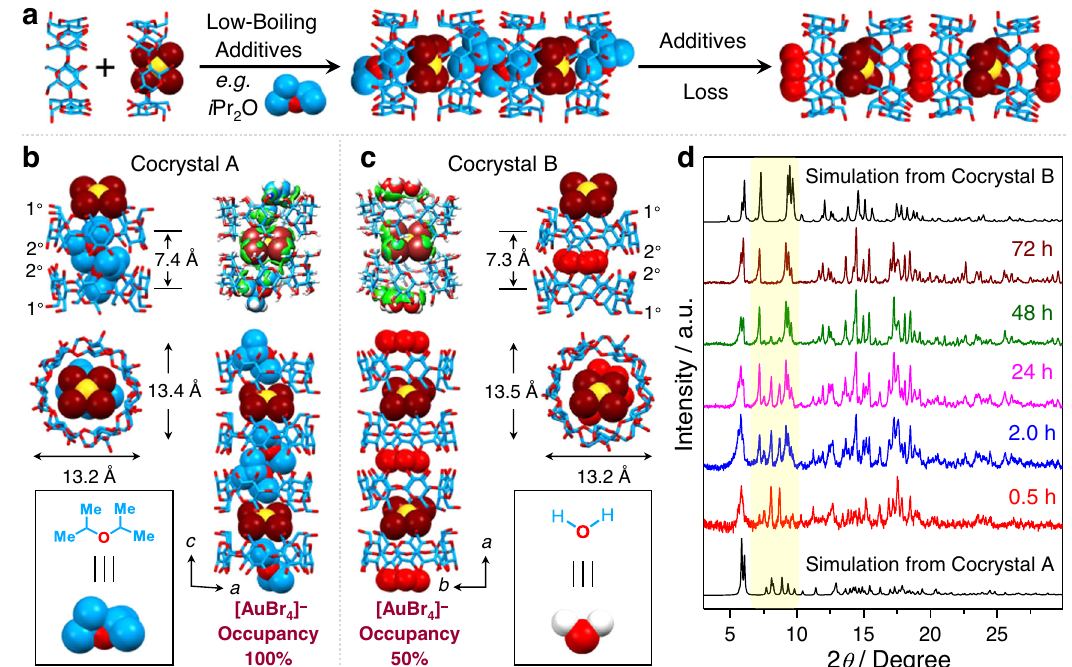
Fig. 4 | Cocrystal-to-cocrystal transformation of the ternary adducts. It shows the possible reason for different additives leading to variable gold-recovery ef fi - ciencies. a Schematicillustrationofthecocrystal-to-cocrystaltransformationupon loss of additives. b Solid-state superstructure and the intermolecular binding iso- surface of the HAuBr 4 ·2( i Pr 2 O) ⊂ 2 β -CD cocrystal, dubbed as cocrystal A, obtained by adding i Pr 2 O into the solution of β -CD and [AuBr 4 ] − followed by standing at room temperature for 12h. c Solid-state superstructure and the intermolecular binding iso-surface of 0.5(HAuBr 4 ) ⊂ 2 β -CD cocrystal, dubbed as cocrystal B,